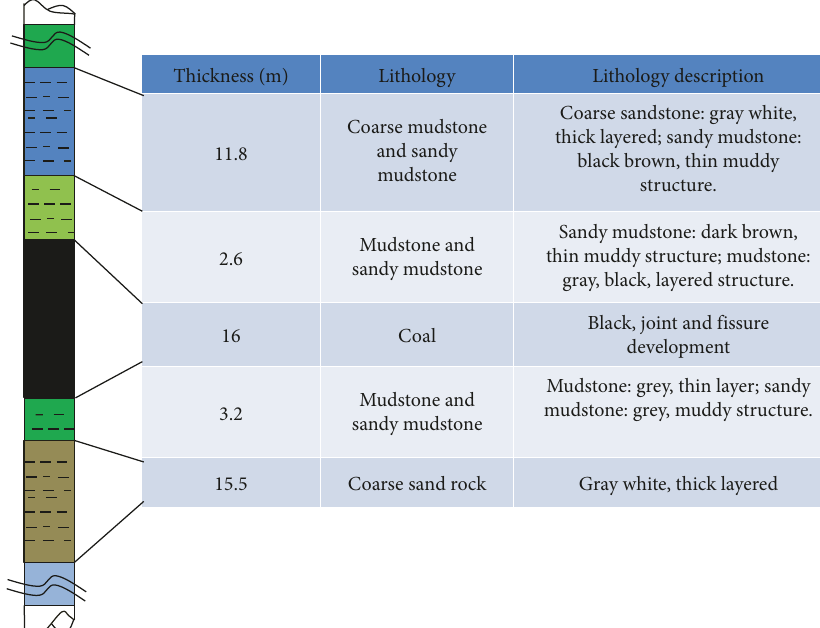
Figure 3: Stratigraphic column and geological description.